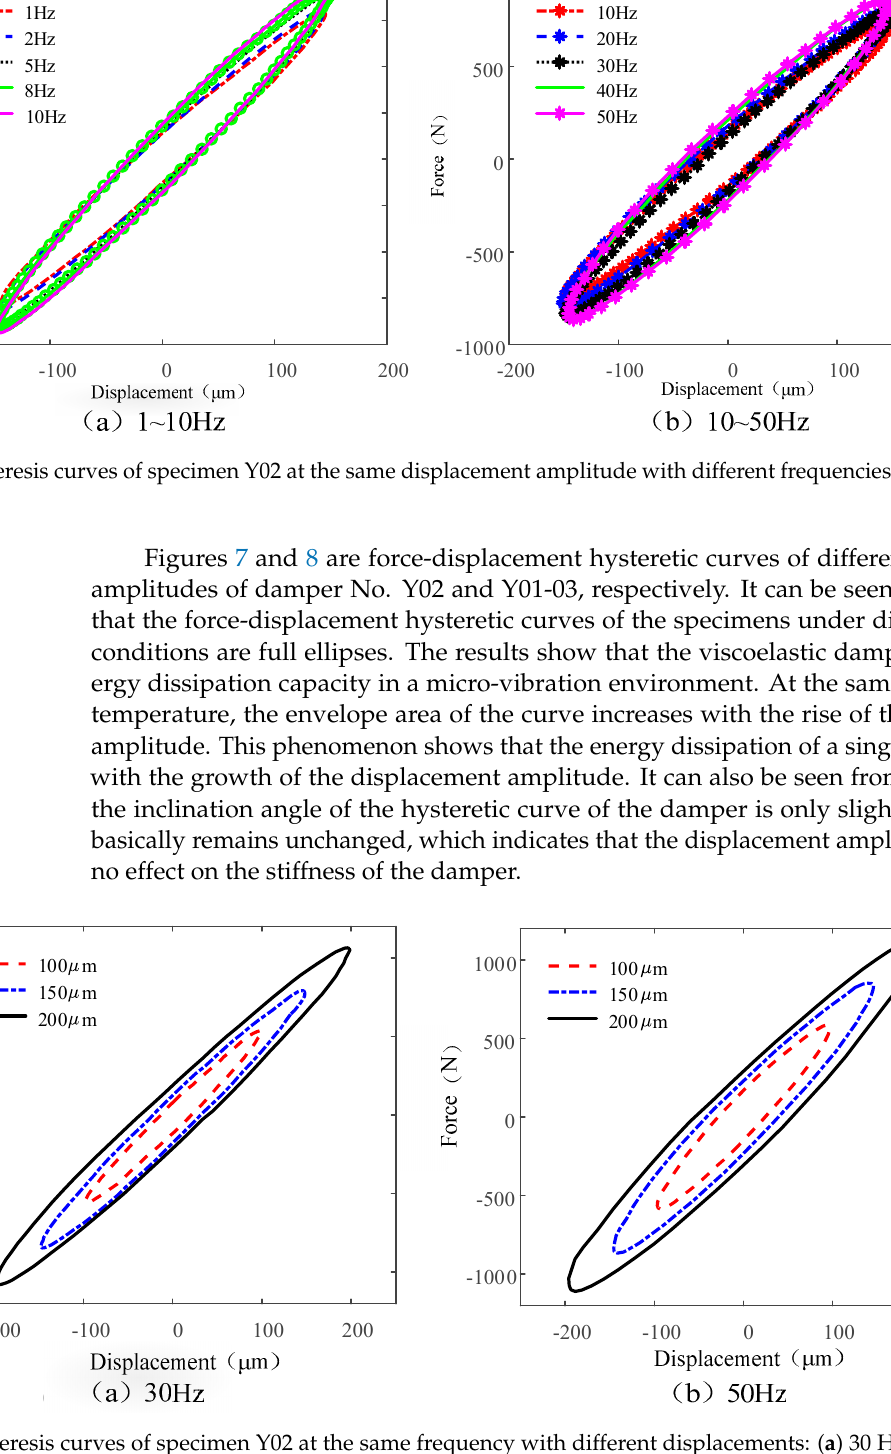
Figure 5. The hysteresis curves of specimen X01 at the same displacement amplitude with different frequencies: ( a ) 150 μ m, ( b ) 300 μ m.